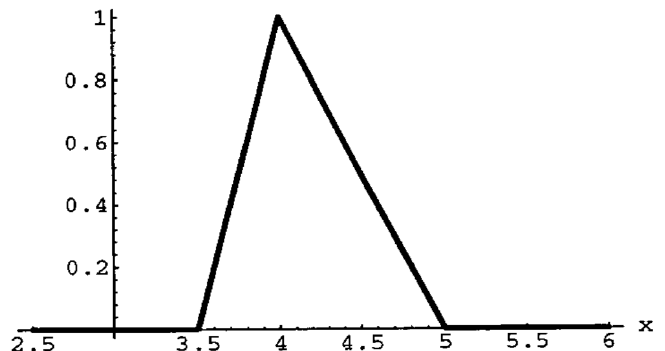
Figure 1. Membership function of marginal propension to save (mps).